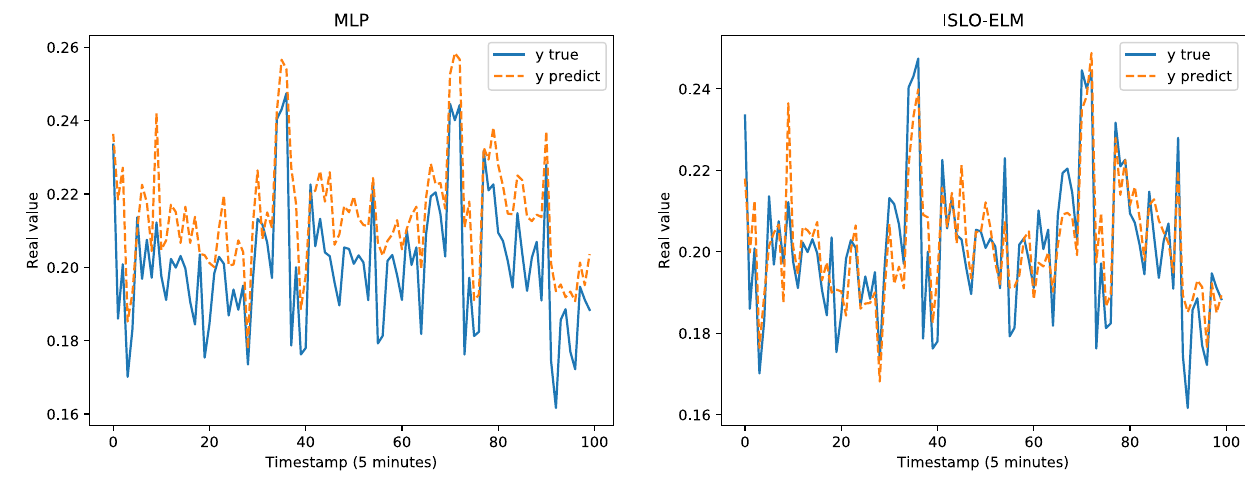
Fig. 9 Prediction results of MLP and our ISLO-ELM model on Google trace RAM data